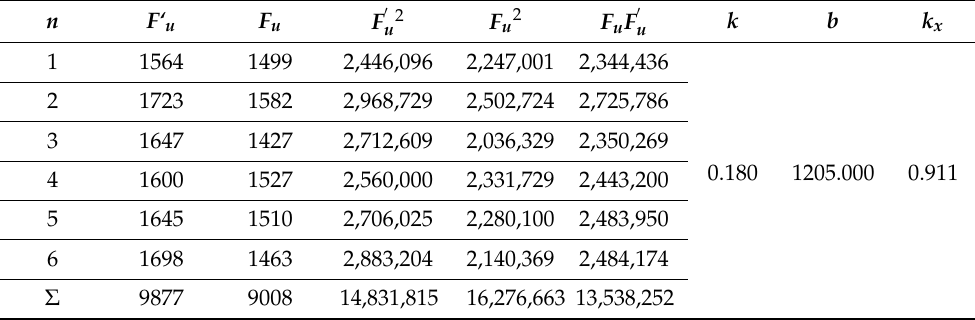
Table 3. Results of calculating the functional dependence for piles with protective shell.